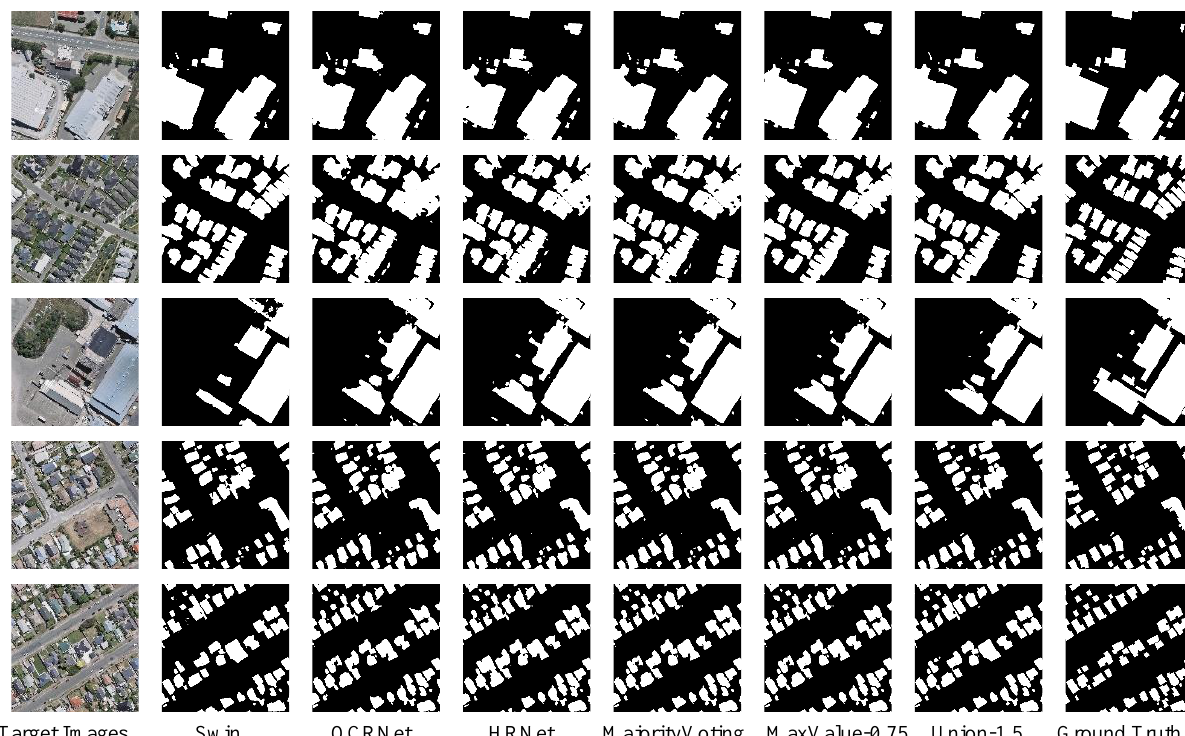
Figure.3 Examples of building extraction maps obtained by different methods for the Case1 Potsdam→WHU.